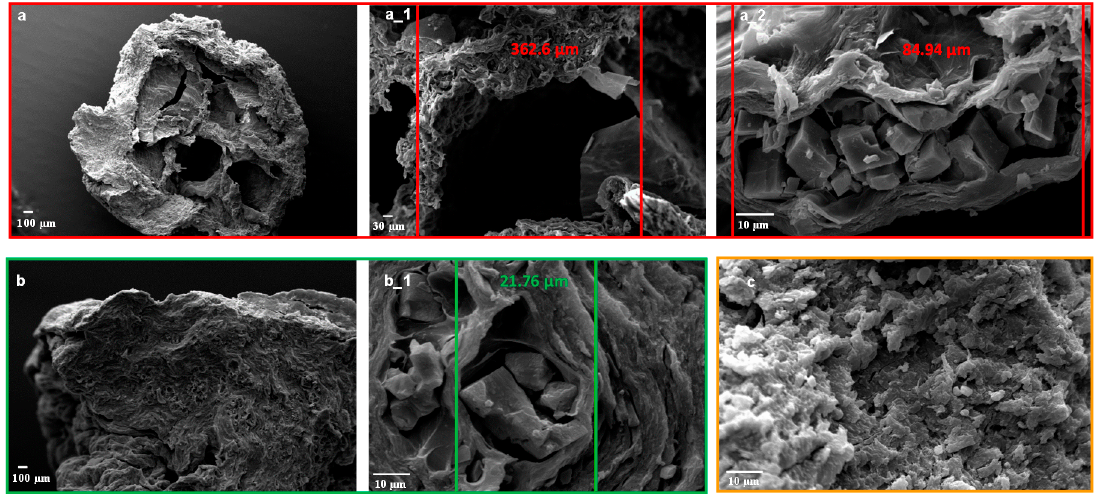
Figure 2. Scanning electron microscopy (SEM) microphotographs of cryo-fractured zinc-alginate beads: F6 ( a , a_1 , a_2 ), F4 ( b , b_1 ), and F1 ( c ) at different magnifications. F6 ( a , a_1 , a_2 ), F4 ( b , b_1 ), and F1 ( c ) at di ff erent